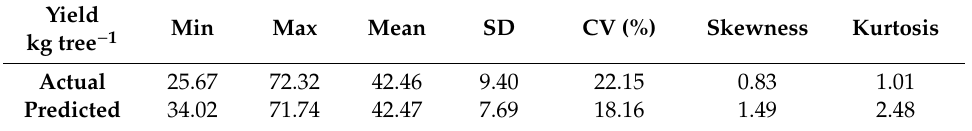
Table 3. Summary statistics of actual and predicted sweet cherry trees yield distribution.